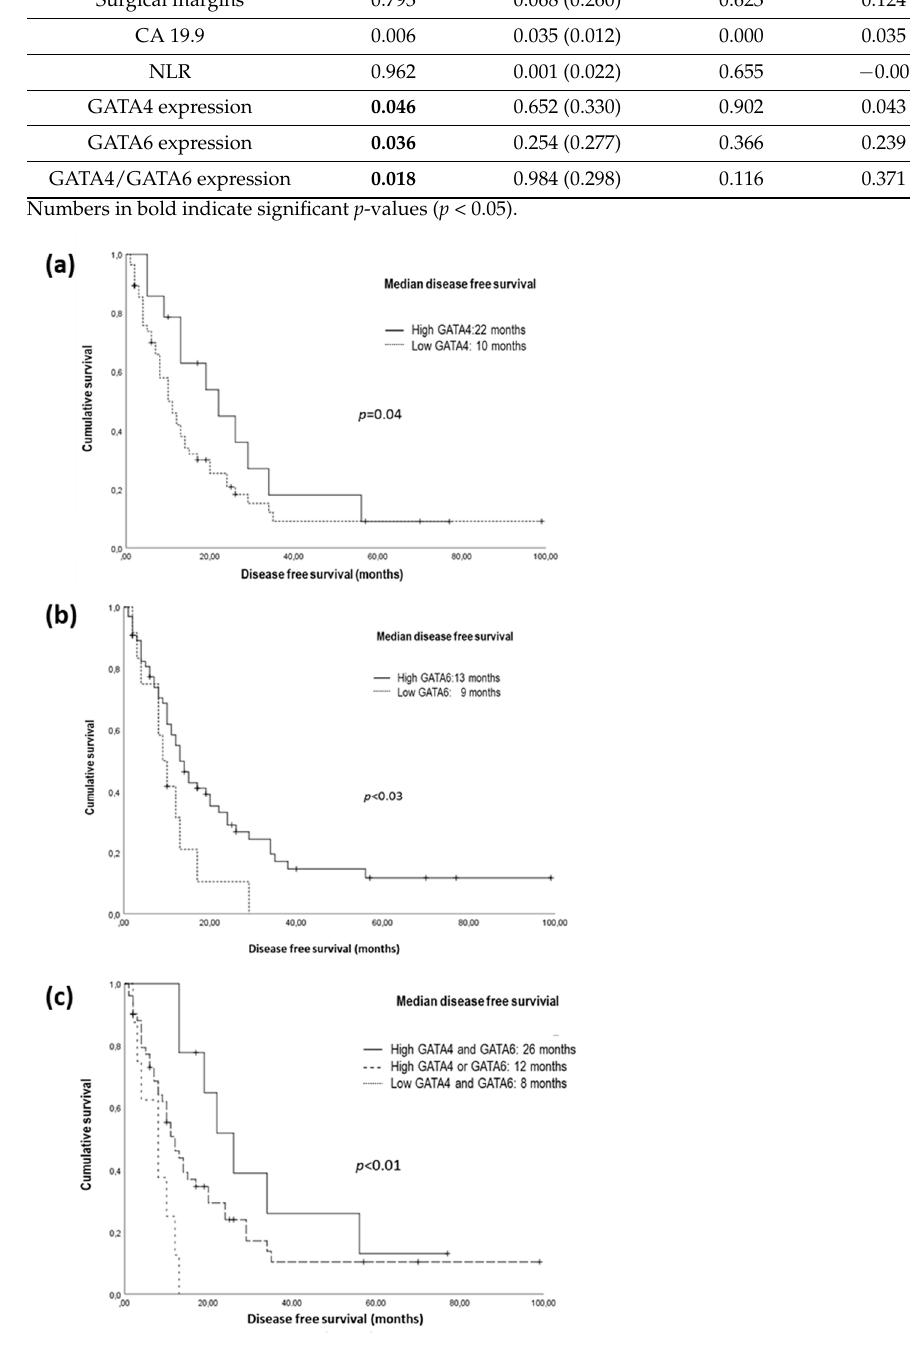
Figure 2. Kaplan–Meier plots of disease-free survival (DFS) by GATA4 and GATA6 tumoral expres- sion. ( a ) Kaplan–Meier plot of DFS by GATA4 expression; ( b ) Kaplan–Meier plot of DFS by GATA6 expression; ( c ) Kaplan–Meier plot of DFS by combined GATA4 and GATA6 expression. Other prognostic factors related to DFS that we identified in the univariate analysis were lymph node invasion, TNM stage, and Ca 19.9 level. In the Cox model, only three independent variables were directly associated with DFS: TNM stage, Ca 19.9 value, and the joint expression of GATA4 and GATA6 (Table 3). When OS was analyzed based on GATA4 and GATA6 expression, we found that patients with simultaneous GATA4 and GATA6 expression tended to have higher OS than those expressing only one or none of the transcription factors respectively [23 m (95% CI: 12.1–33.8) vs. 18 m (95% CI: 13.5–22.5) vs. 12 m (95% CI: 5.2–18.7); p = 0.078]. The only variable that showed a significant relation- ship with OS was the level of Ca19.9 (Table 4). Table 3. Univariate Cox proportional hazards regression survival analysis. Variable